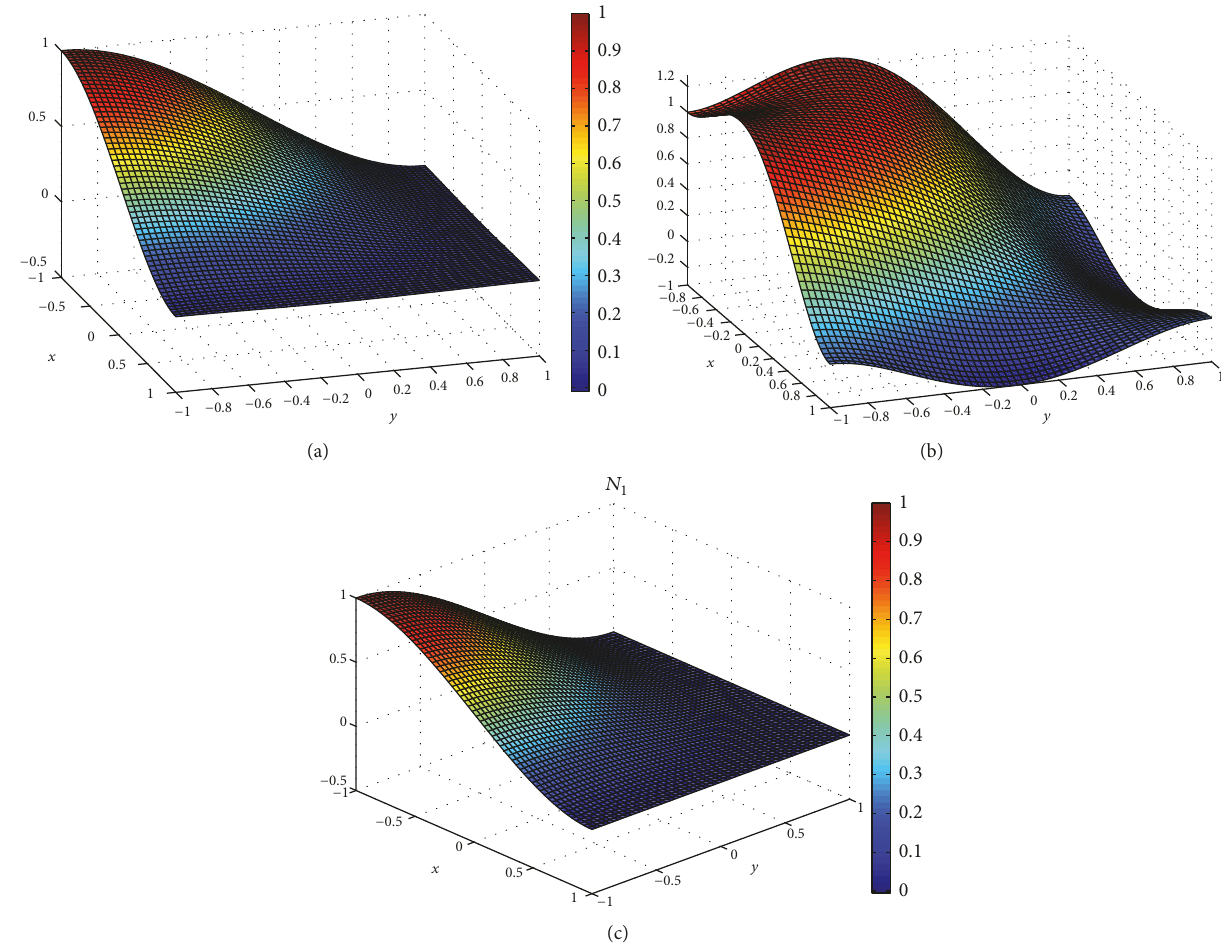
Figure 2: Variation of dynamic shape functions with vibrational frequency and comparison to Hermitian shape functions. The plot of first DFE shape function, 𝑁 1𝜔 (𝑥,𝑦) , for 𝛾 𝑥𝑦 = 0.000001 (a) and 𝛾 𝑥𝑦 = 2 (b). The first Hermitian shape function, 𝑁1 , is plotted in (c).